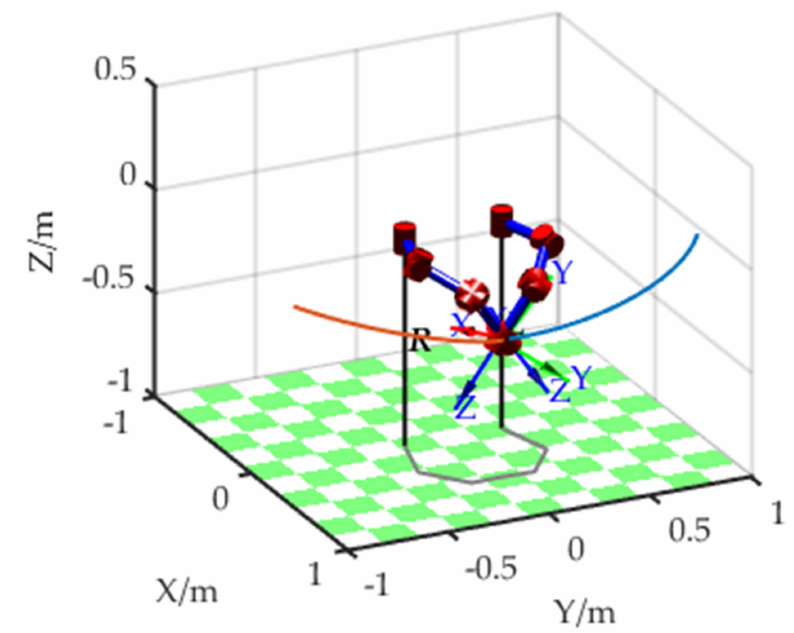
Figure 6. Manipulators of the dual-arm robot collide at the goal point.